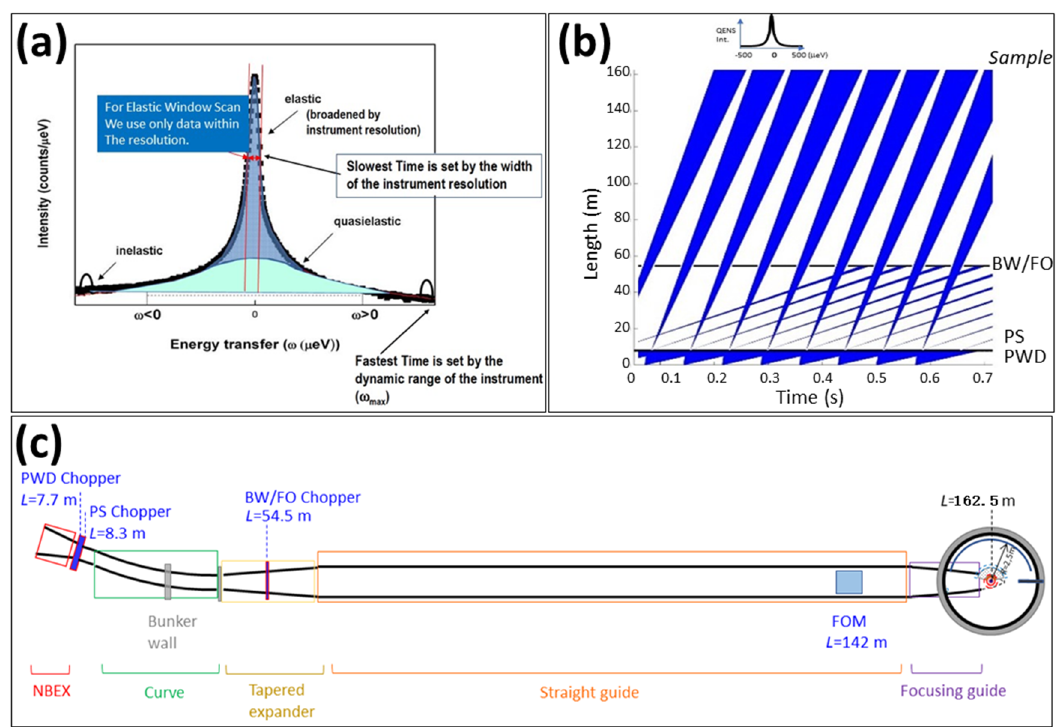
Figure 1. ( a ) Schematic description of an inelastic neutron scattering measurement, highlighting the three regions of interest: inelastic, quasielastic, and elastic; ( b ) Time structure diagram and ( c ) top view beamline layout obtained with the current chopper cascade of MIRACLES.